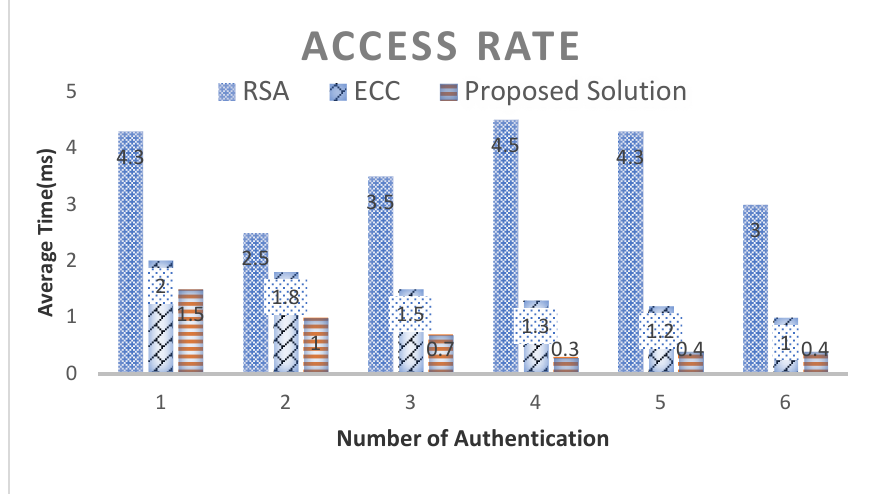
Figure 12. Access rate of authentication.